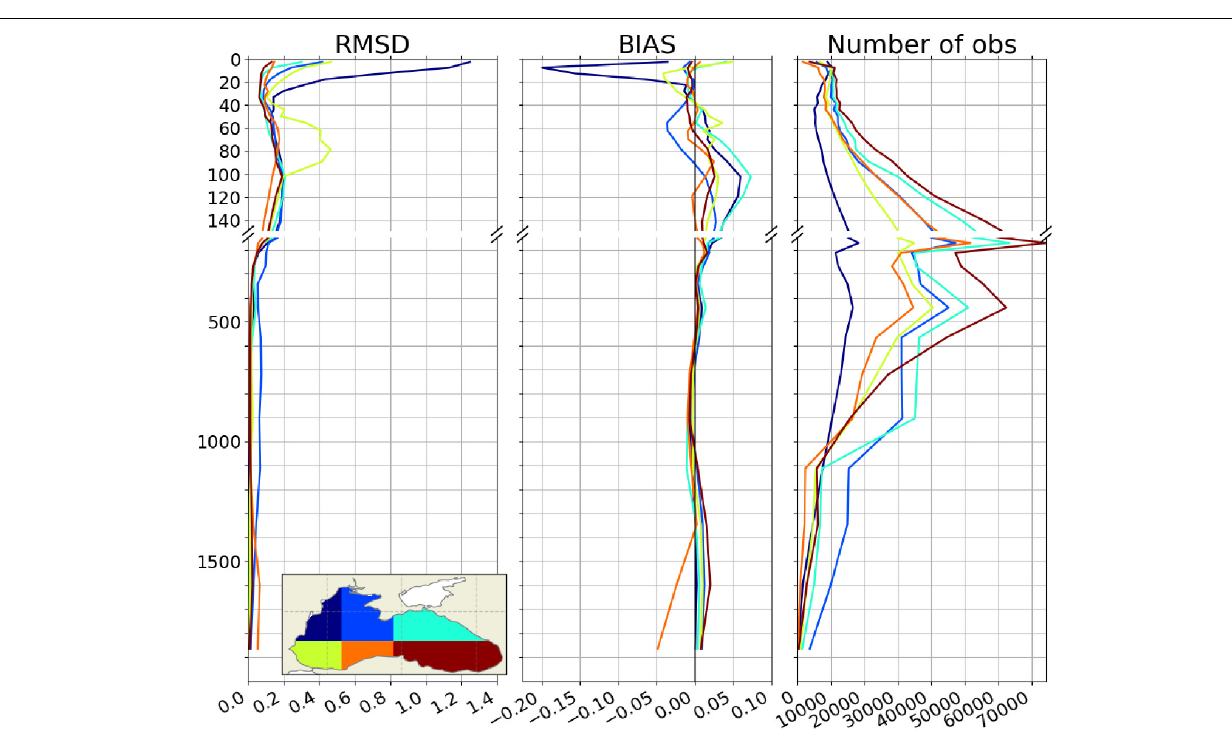
Frontiers in Marine Science |